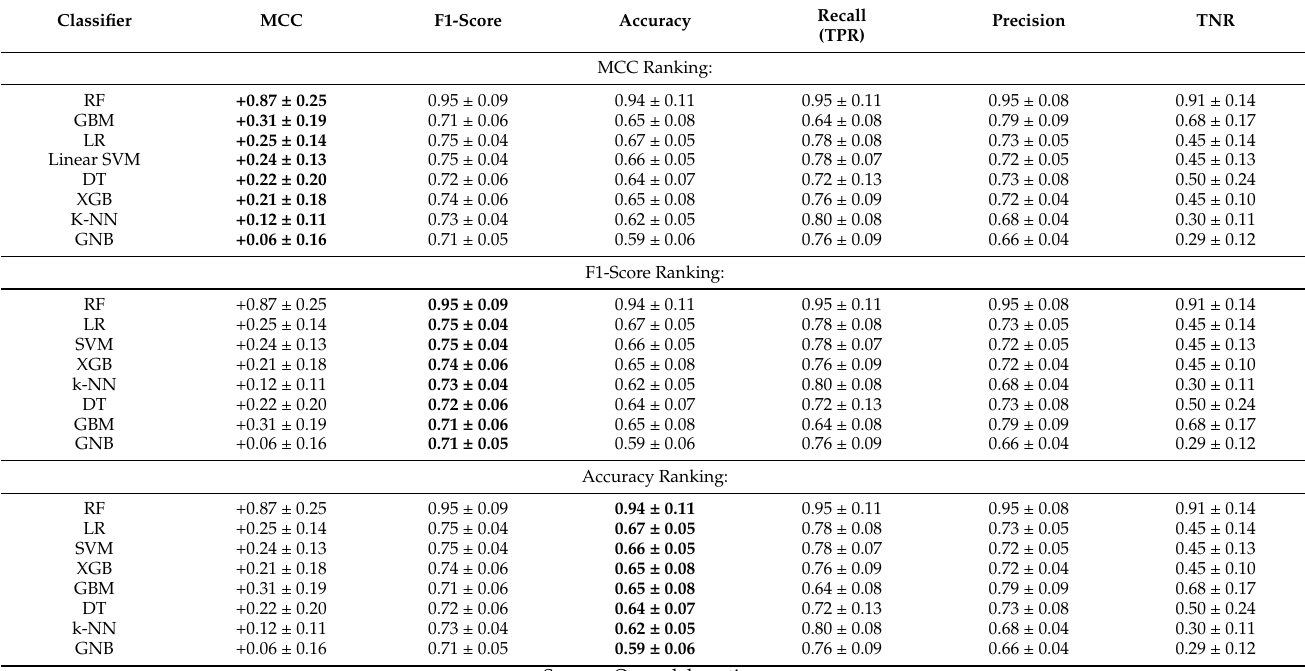
Table 13. Gender Classification Performance